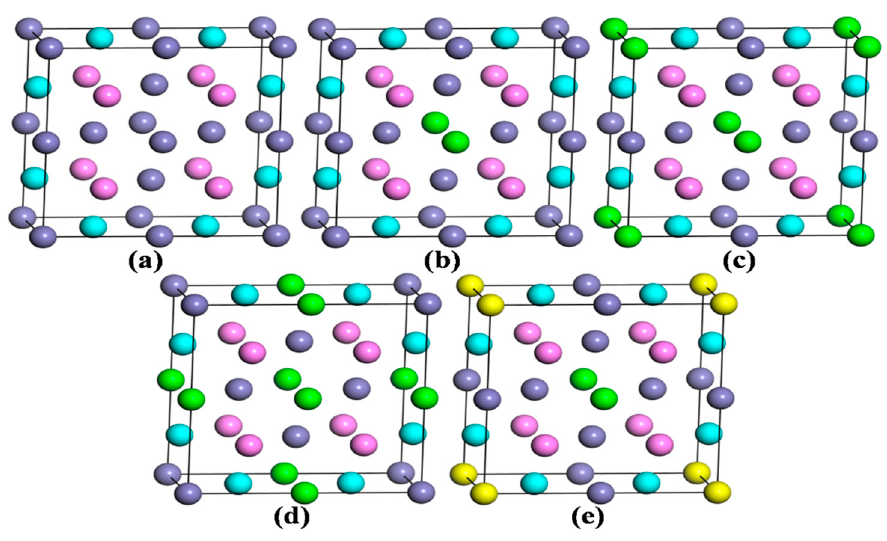
Figure 5. Schematic diagram of models for calculations: ( a ) Fe 8 Cr 4 Ni 4 ; ( b ) Fe 7 Cr 4 Ni 4 Al; ( c ) Fe 6 Cr 4 Ni 4 Al 2 ; ( d ) Fe 5 Cr 4 Ni 4 Al 3 ; ( e ) Fe 6 Cr 4 Ni 4 AlSi.